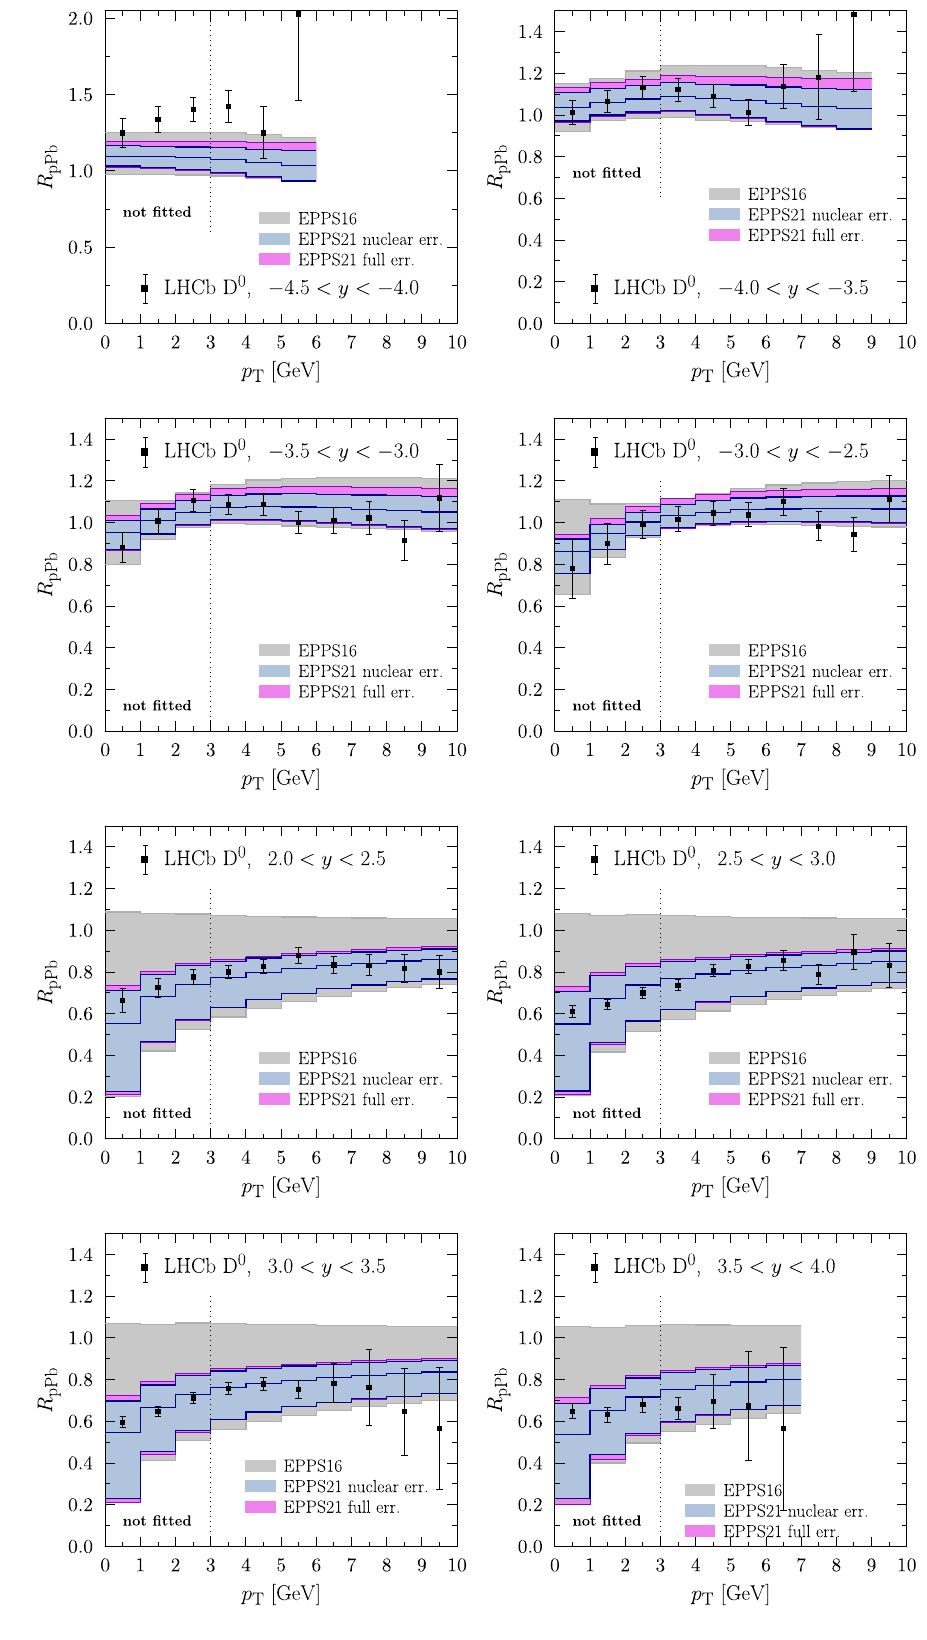
Fig. 14 The LHCb D-meson data [4] compared with the EPPS21 and EPPS16 analyses. The solid blue lines show our central results, inner blue bands the nuclear uncertainties, and the purple bands the total uncertainty. The grey bands correspond to the EPPS16 results. The points below p T = 3GeV were not included in the analysis. The experimental data have been scaled with the normalization factors indicated in Table